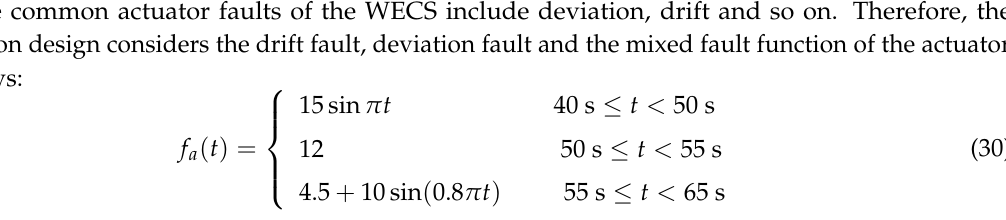
Figure 6. Wind energy conversion coefficient value C p without fault.